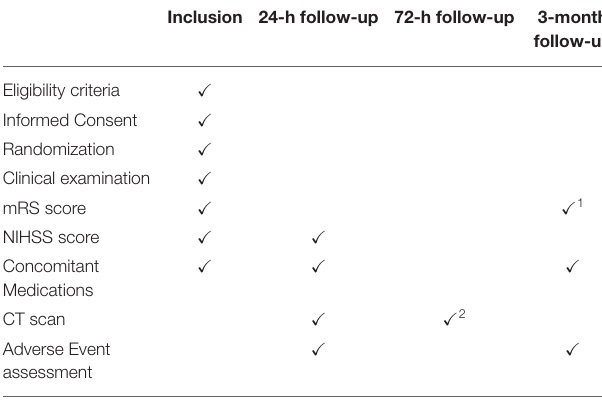
TABLE 1 | Data collection during the